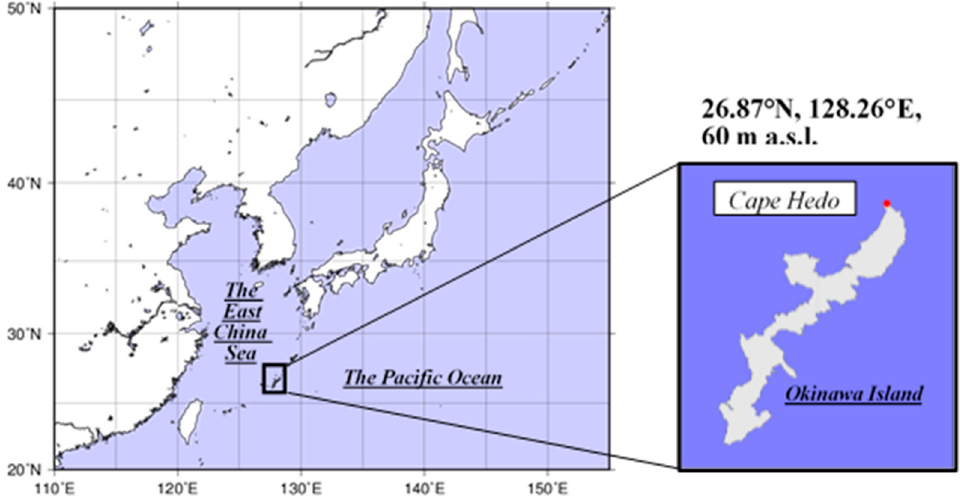
Figure 1. A map of the observation site.